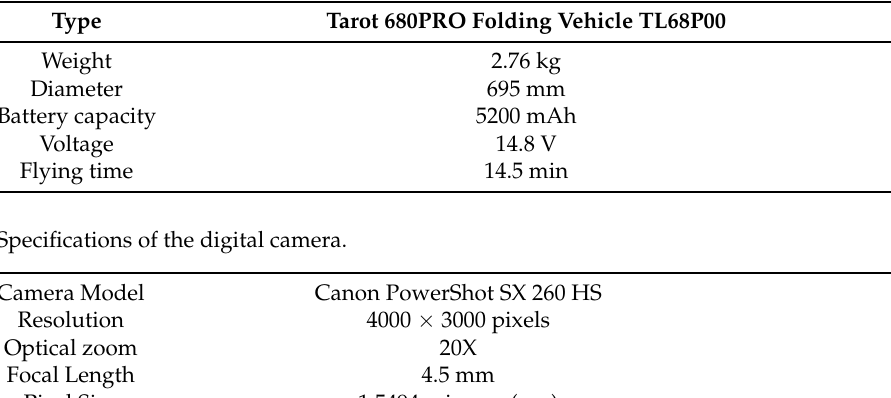
Table 2. Specifications of the UAV platform.